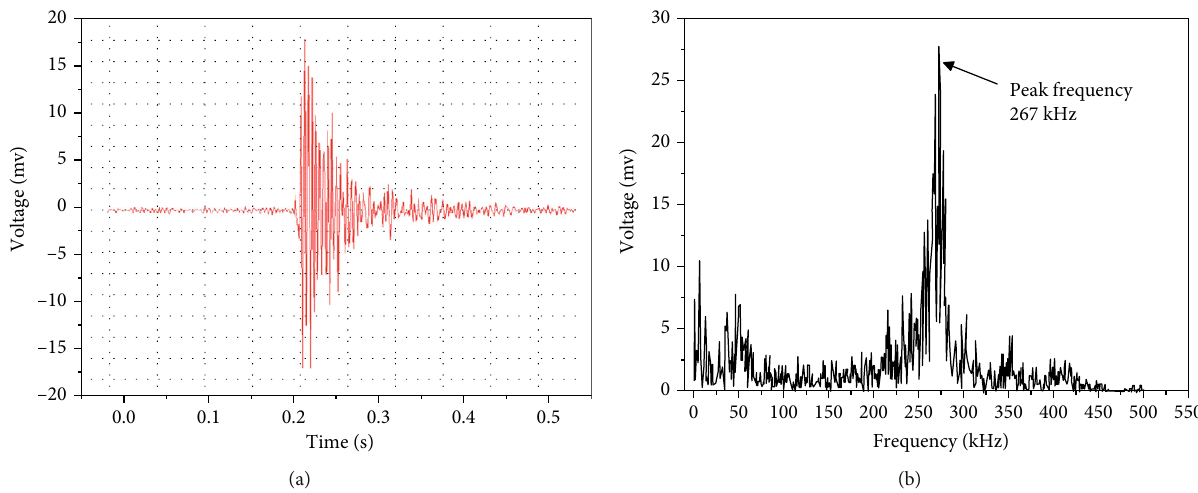
Figure 16: Frequency domain signal treatment to obtain the peak frequency of a fracturing event. (a) Original waveform of an AE event. (b) Plot of frequency against voltage to obtain the main